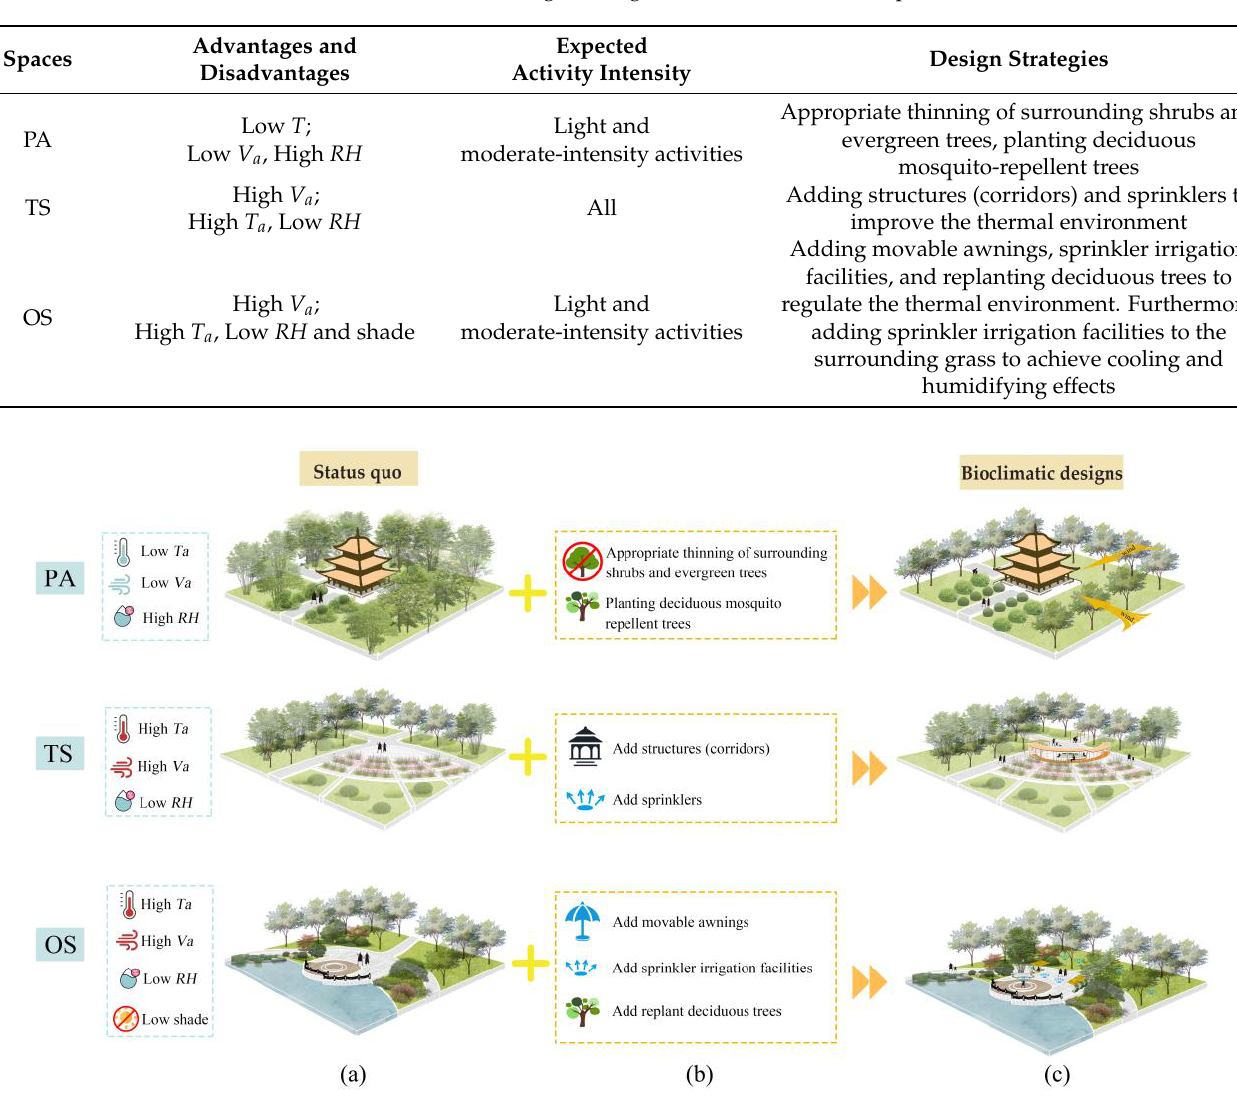
Figure 12. Bioclimatic design sketches of each space (present situation ( a ), bioclimatic design strategies ( b ), and 3D graphs after bioclimatic designs ( c )). Table 11. Bioclimatic design strategies for the three outdoor spaces.